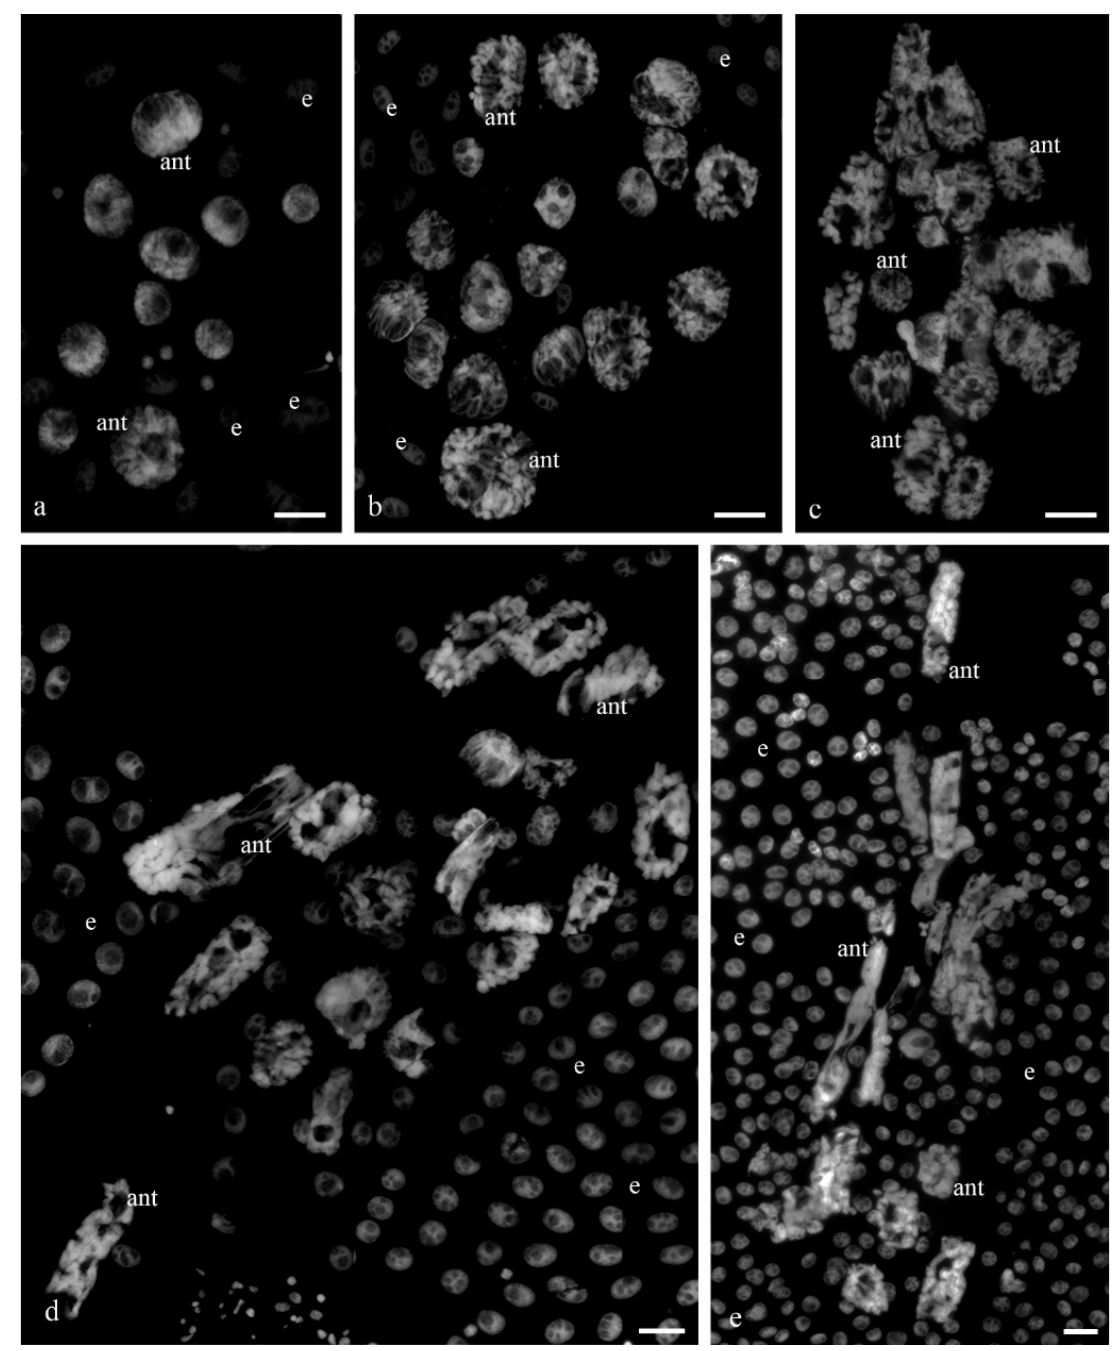
Figure 1. A general view of the antipodal complexes of the wheat embryo sacs at various stages of differentiation and programmed cell death. DAPI. Stages: early differentiation—( a ); middle differentiation—( b ); late differentiation—( c ); stage of early PCD—( d ); middle PCD—( e ). ant—antipodal nuclei; e—endosperm nuclei. The scale is 30 µm.